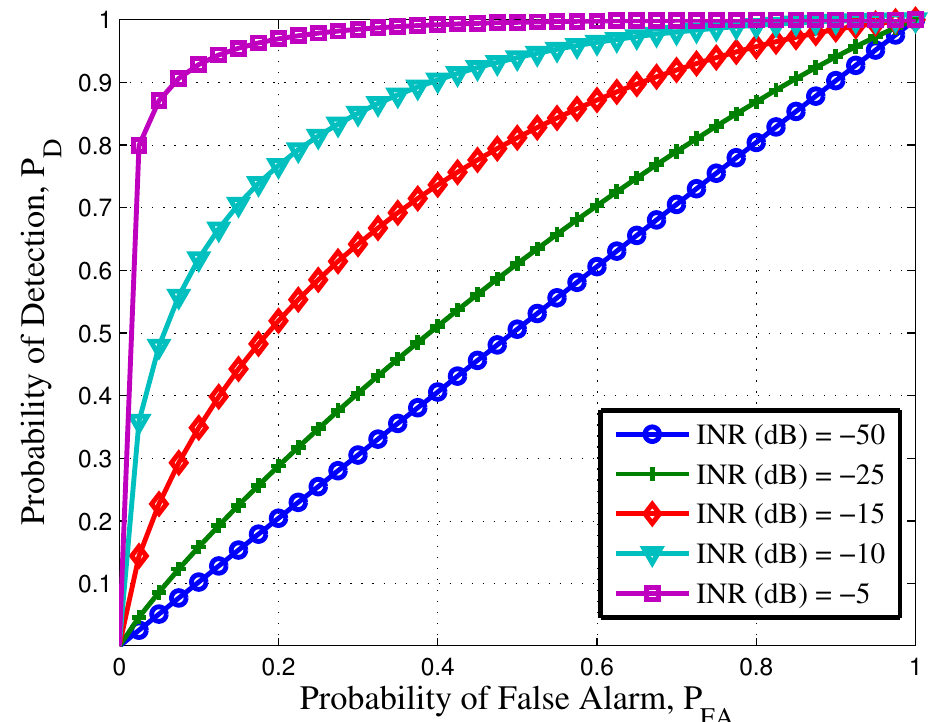
Figure 2. Receiver operating characteristics for UWB system with different interference to noise ratio